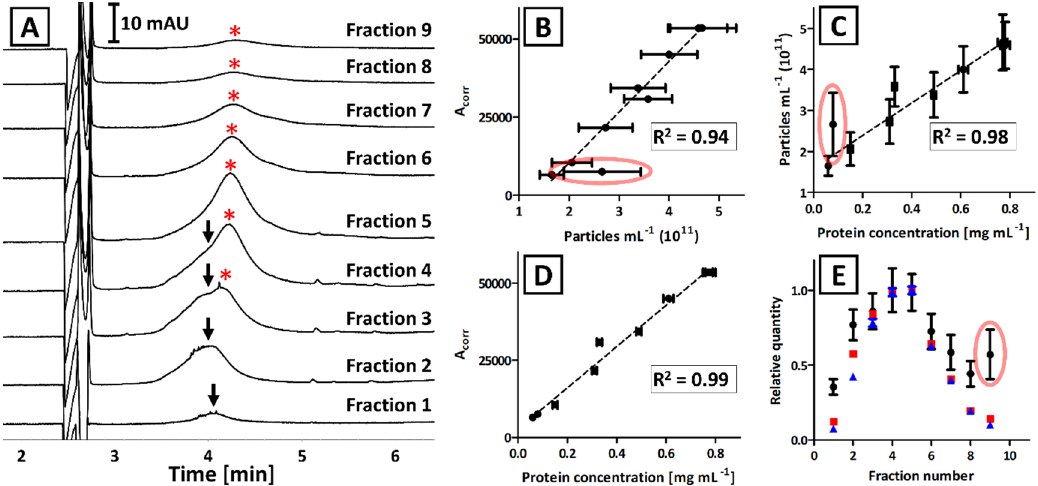
Figure 4. The analysis results of isolates that were obtained from GFP-modified Pectobacterium odoriferum Car1 with IDGUC. ( A ) CE analysis of certain fractions. Arrows and asterisks (*) indicate signals generated by two subpopulations of EVs. ( B – E ) Comparison of CE, NTA, and BCA analyses of separated fractions. Error bars represent the standard deviation of measurements. Coefficients of determination (R 2 ) refer to the linear correlation between certain analyses and do not include the outlier (circled in red). ( E ) The traces correspond to the relative quantity of EVs determined with CE (red), BCA (blue), and NTA (black) in certain fractions.